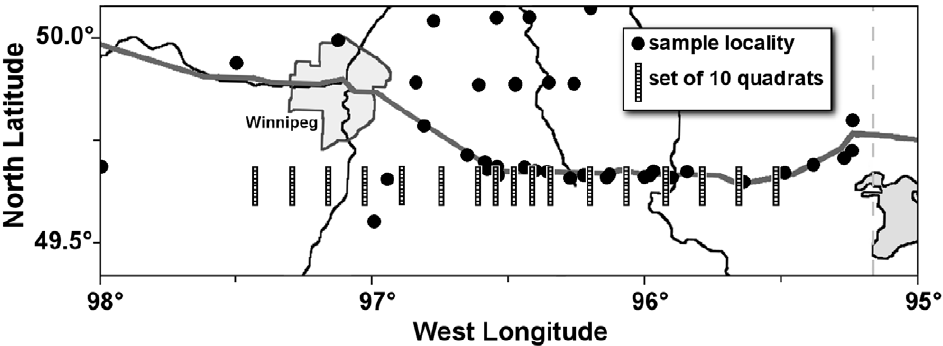
Figure 3. Locations of the 17 sets of 1 km 2 quadrats across southeastern Manitoba used to determine extent of forest cover from 1:15,000 scale topographic maps. Sample localities for toads in the vicinity of the quadrats are depicted as black